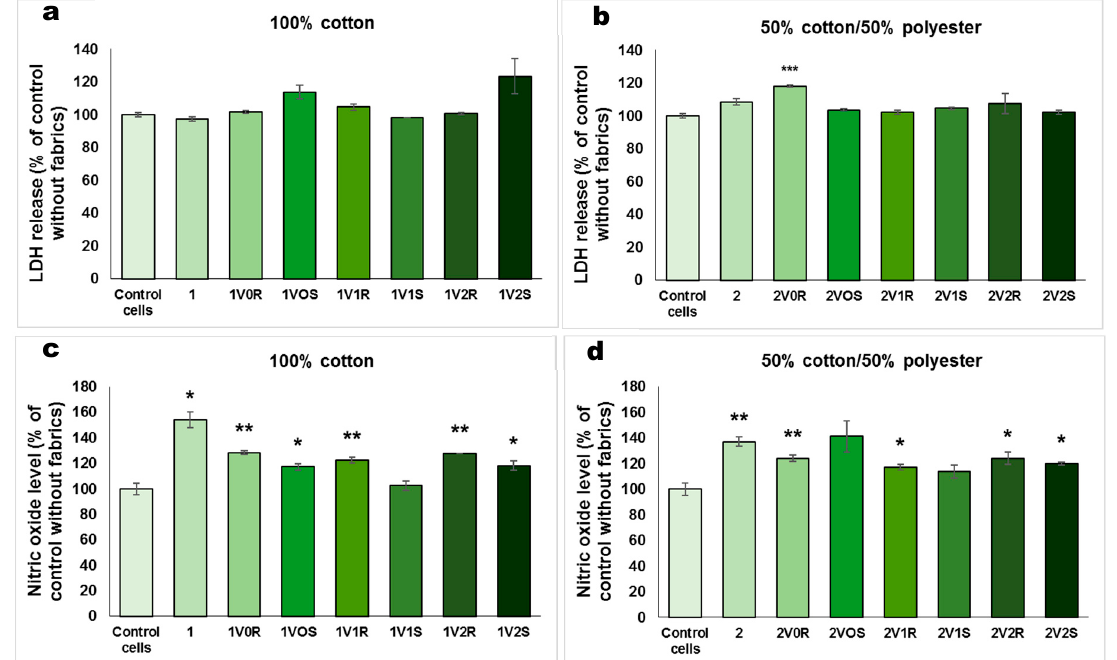
Figure 4. Biocompatibility in terms of LDH release ( a , b ) and NO level ( c , d ) for 100% cotton and 50% cotton/50% polyester fabrics treated in different experimental variants with sage (S) and rose (R) microcapsules, that were incubated for 12 h with human dermal fibroblasts cultured on inserts. Data are represented relative to control cells without fabrics as mean ± standard deviation (SD) (n = 3). * p